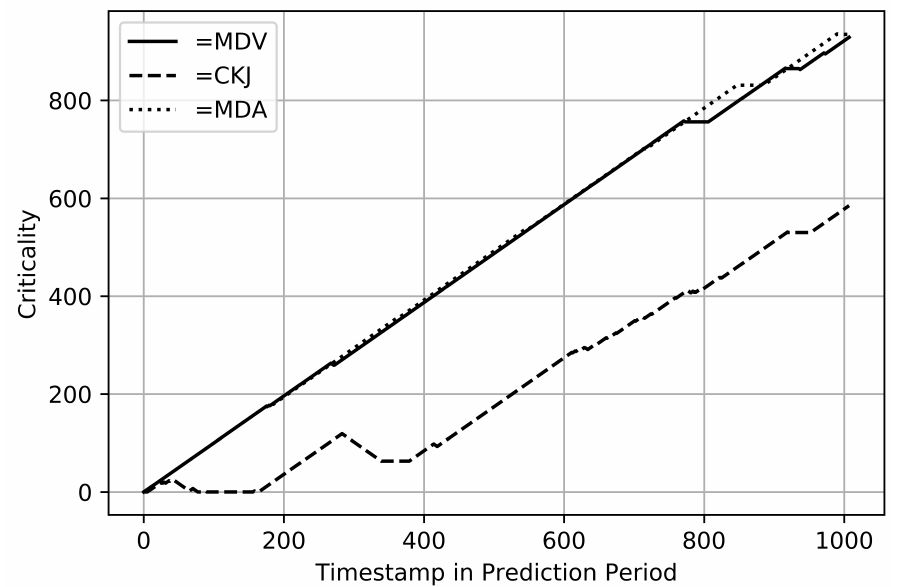
Figure 5. Development of